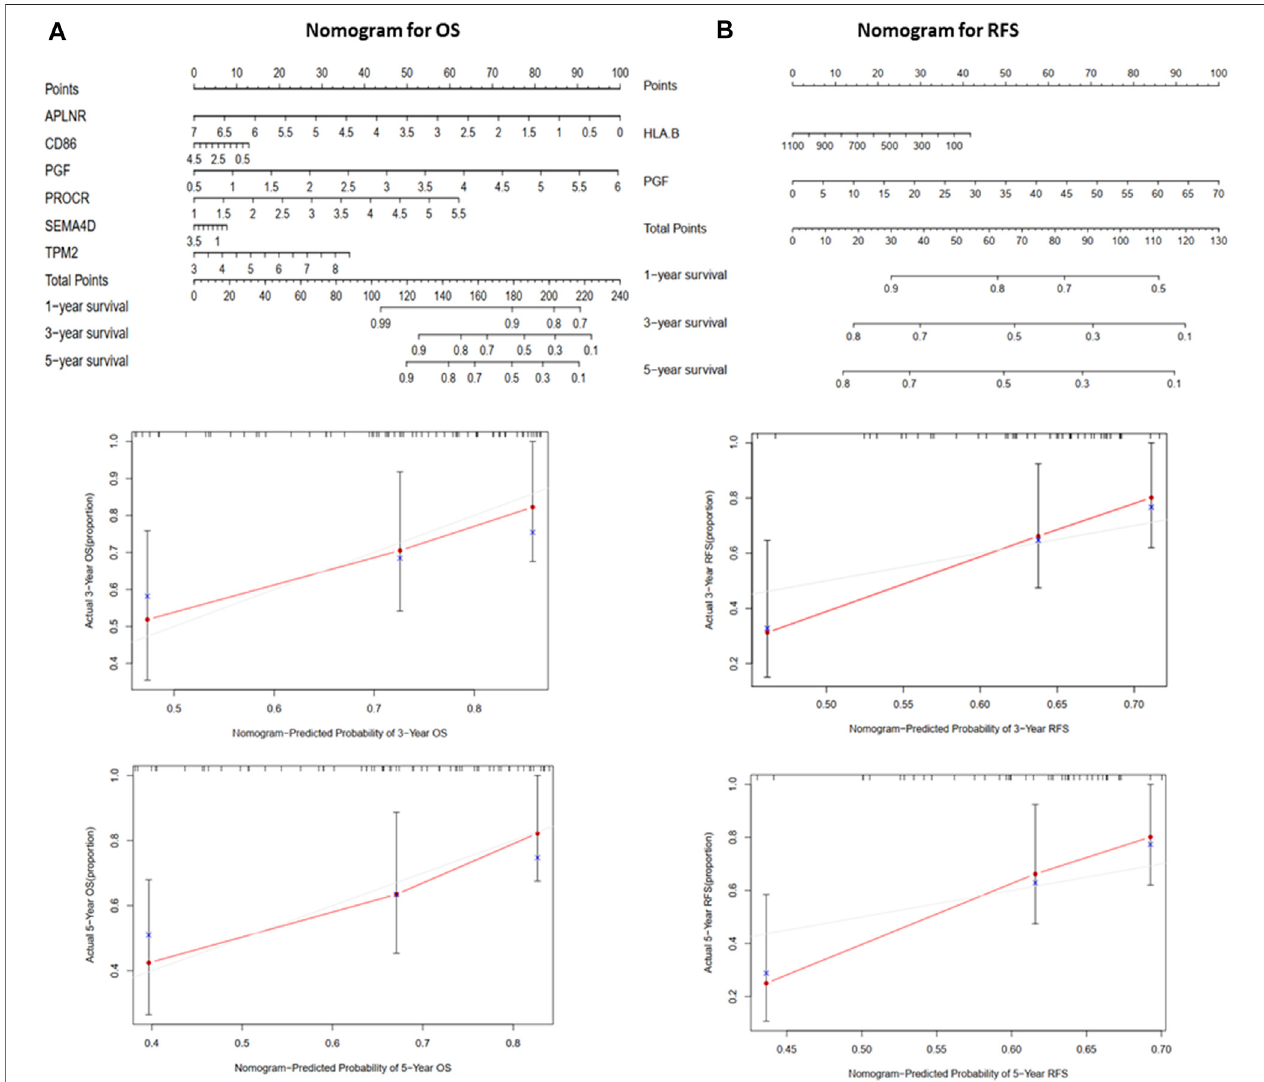
FIGURE 5 | The nomograms for predicting 1-, 3-, and 5-year OS and RFS of the validation cohort (TARGET). (A) Nomogram for predicting 3- and 5-year OS and calibration plots. (B) Nomogram for predicting 3- and 5-year RFS and calibration plots.